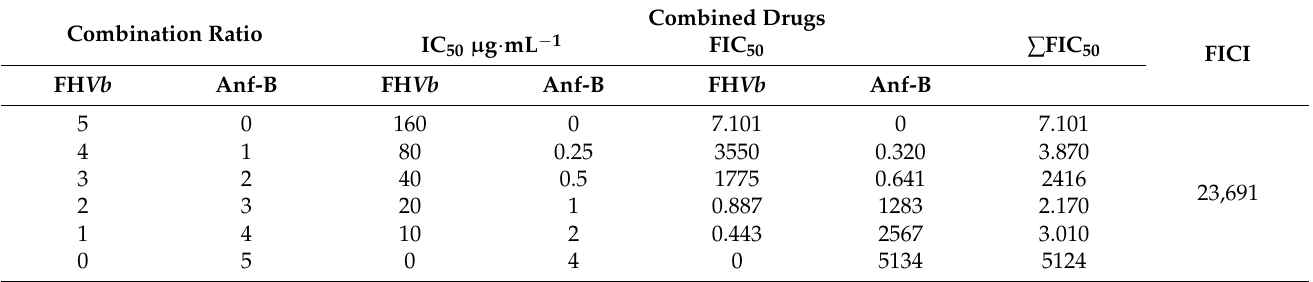
Table 4. Assessment of drug interaction between the hexane fraction of Vernonanthura brasiliana (L.) H. Rob with amphotericin-B against Leishmania amazonensis in the promastigote form. Combination